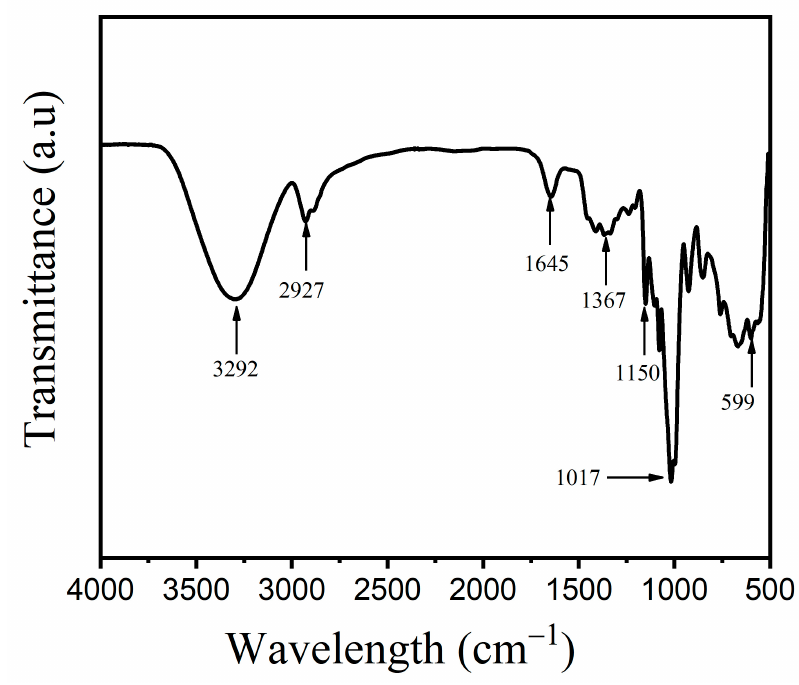
Figure 9. Fourier transform infrared (FTIR) spectra of taro peel starch film.